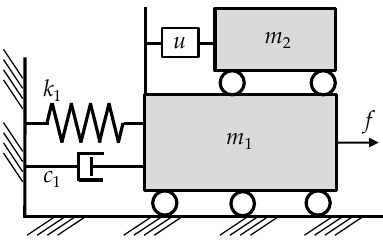
Figure 1. Illustration of the mathematical model of a building with an active mass damper.